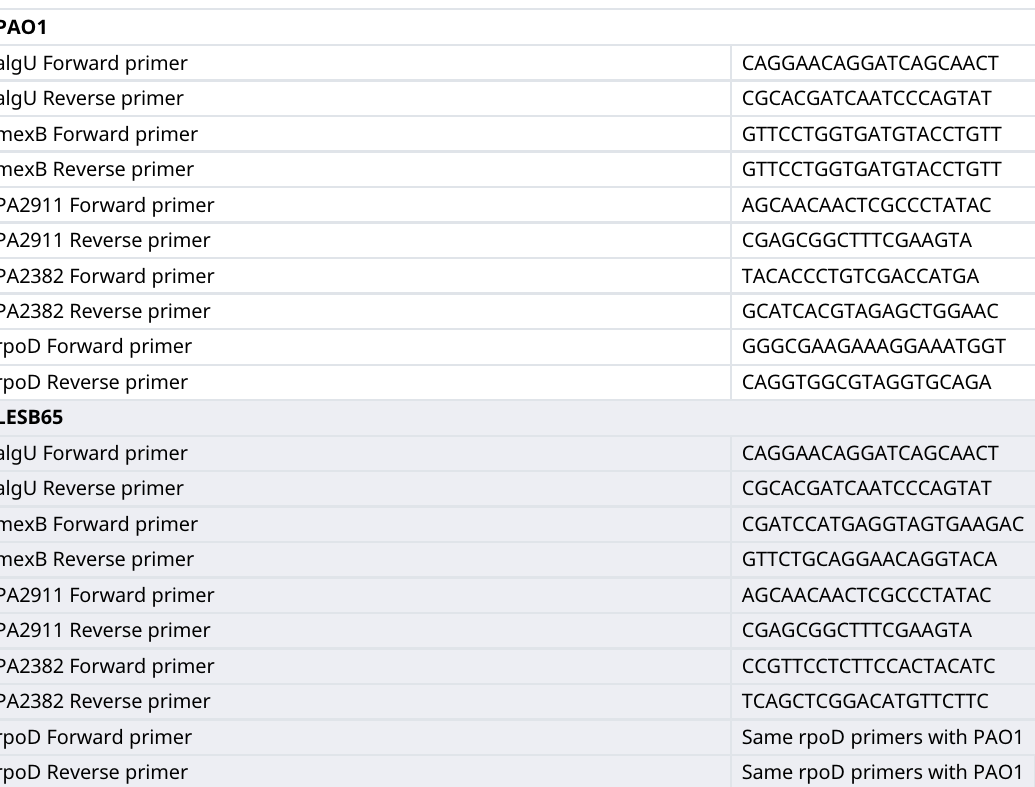
Table 4. Primer sequences used in the qPCR experiments for PAO1 and LESB65.